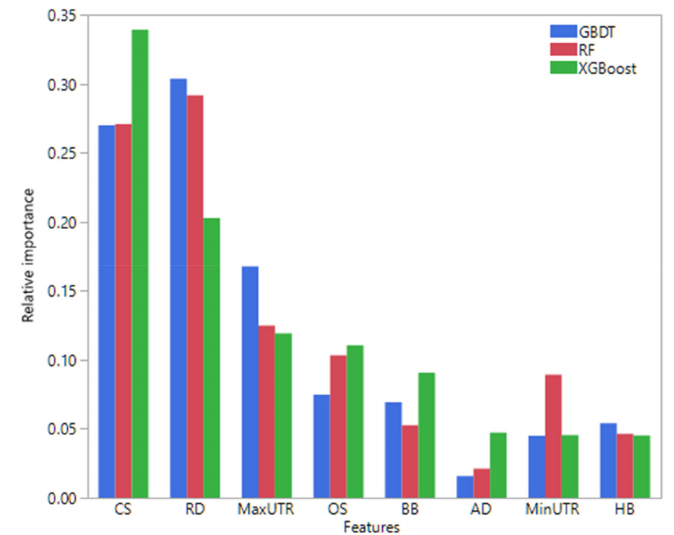
Figure 6. Relative importance of features affecting results of three different metamodels (GBDT, RF, and XGBoost). Clone size, the number of rainy days, and maximum upper temperature ranges were the three most important features across